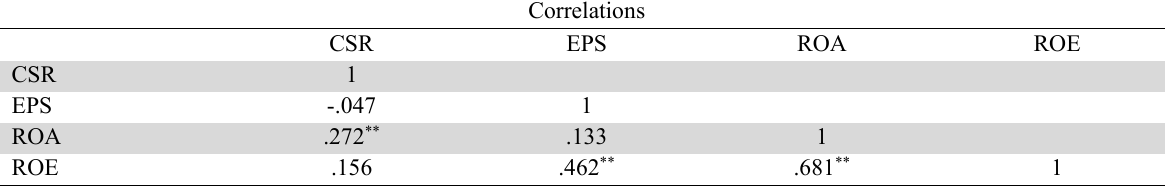
Correlation Analysis for Domestic-Owned 12 Insurance Companies Correlations CSR EPS ROA ROE CSR 1 -.047 .272 ** .133 ROE .156 .462 ** .681 **